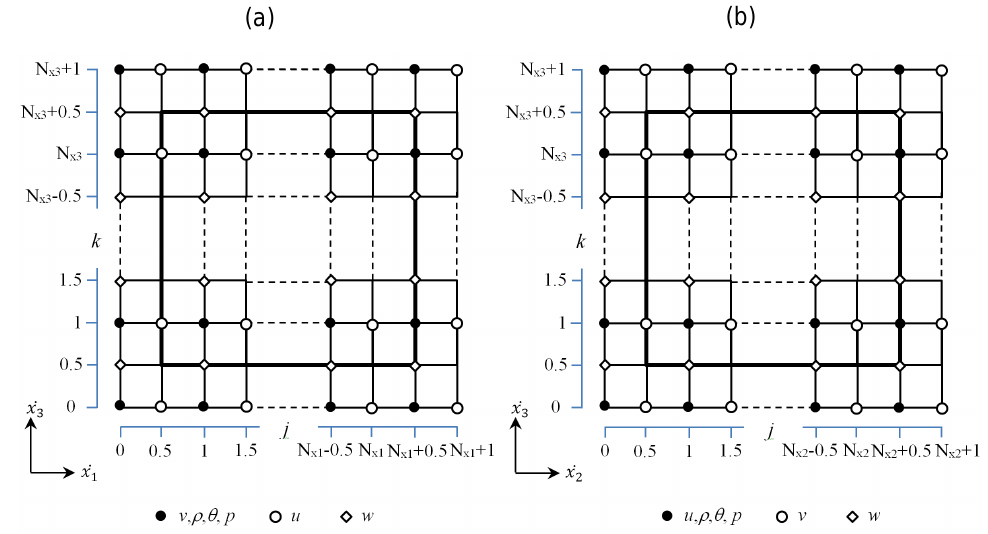
Figure 2. Sketch showing the staggering of the variables of a domain in (a) the x – z direction and (b) y – z direction for a model domain with size N x 1 × N x 2 × N x 3 . The thick line denotes the model domain boundaries. For simplification a uniform grid is